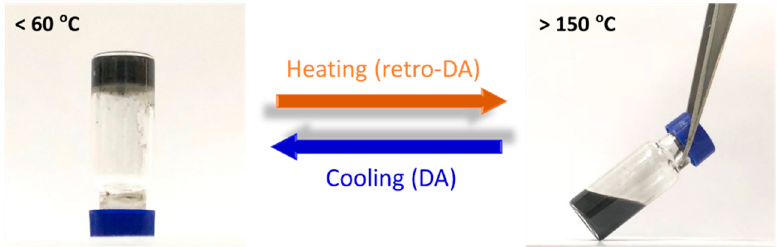
Figure 11. Photographic images taken from a DA-PEBF-2 / DMSO mixture (60 wt % in DMSO) under a heating / cooling cycle, demonstrating a thermally reversible sol–gel transformation through DA / retro-DA